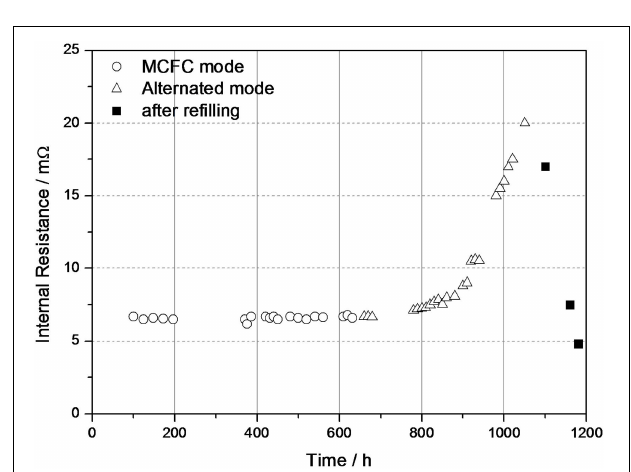
FIGURE 2 | Evolution of internal ohmic resistance in the reverse MCFC cell during the fuel cell and the alternated periods of testing. Resistance data taken during the refilling period at the end of the testing campaign are also